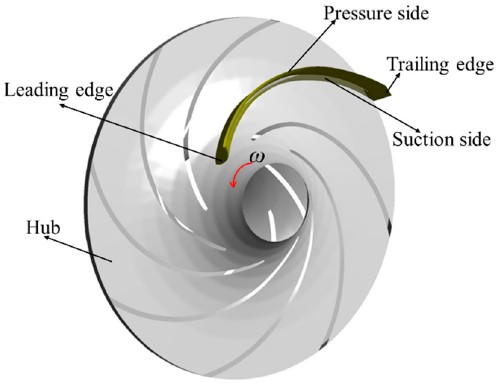
Figure 2. Impeller components.